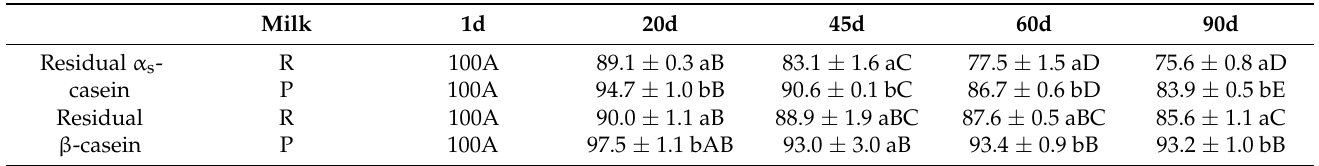
Figure 1. Urea-polyacrylamide gel electrophoretograms of hard Xinotyri cheese made with raw ( A ) or pasteurized ( B ) milk during ripening and storage. Lanes 1: total goat casein; 23: 1-d cheese; 4–5: 20-d cheese; 6–7: 45-d cheese; 8–9: 60-d cheese; 10–11: 90-d cheese. Table 4. Residual α s - and β -casein of hard Xinotyri cheese made from raw (R) or pasteurized milk (P), during ripening and storage (i)